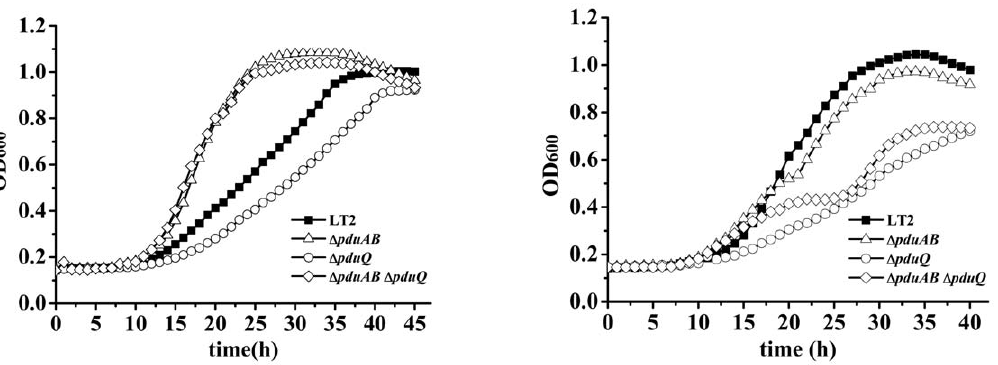
Figure 5. A D pduQ mutant is unimpaired for growth in a strain unable to form MCPs ( D pduAB ). Cells were grown on 1,2-PD minimal medium supplemented with 40 or 150 nM CN-Cbl (vitamin B 12 ).